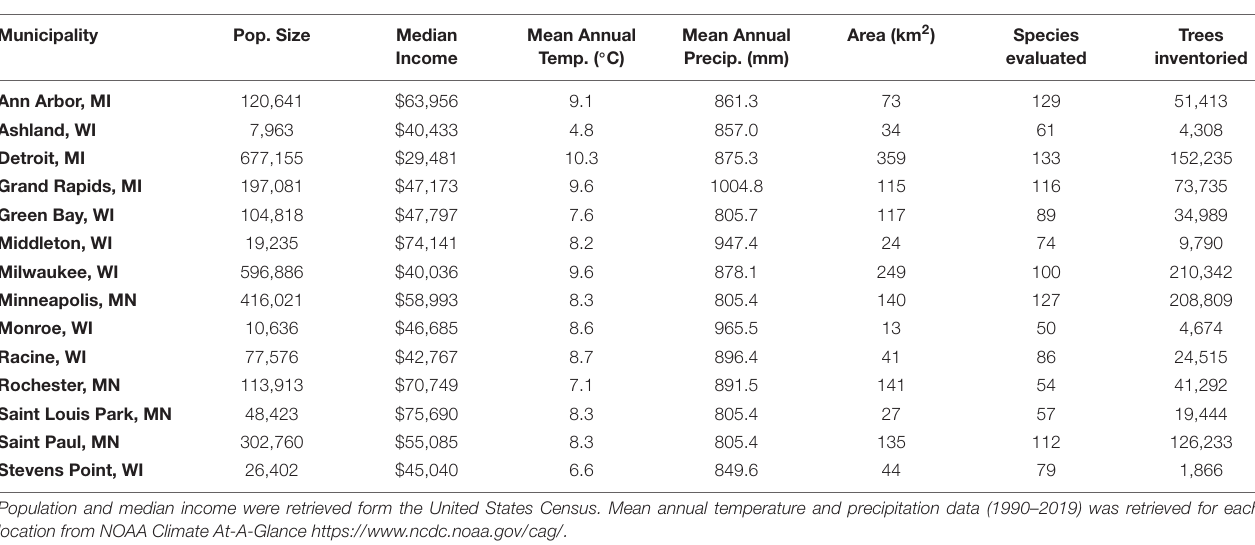
TABLE 1 | Cities included in vulnerability analysis.